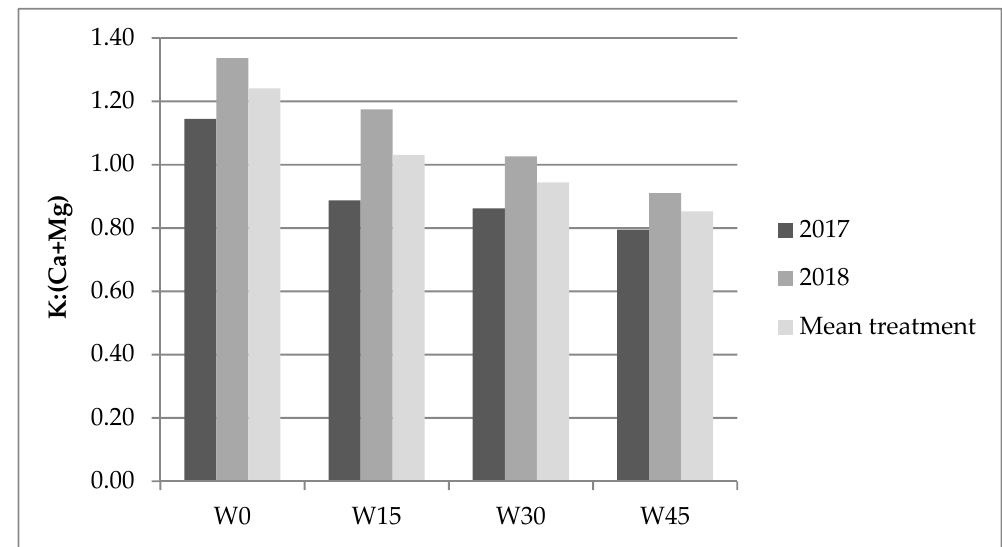
Figure 7. The K: (Ca + Mg) ratios in maize grain. W0—the control with no stillage treatment, W15—15 m 3 of stillage per hectare, W30—30 m 3 of stillage per hectare, W45—45 m 3 of stillage per hectare. The same letter means not significantly di ff erent.